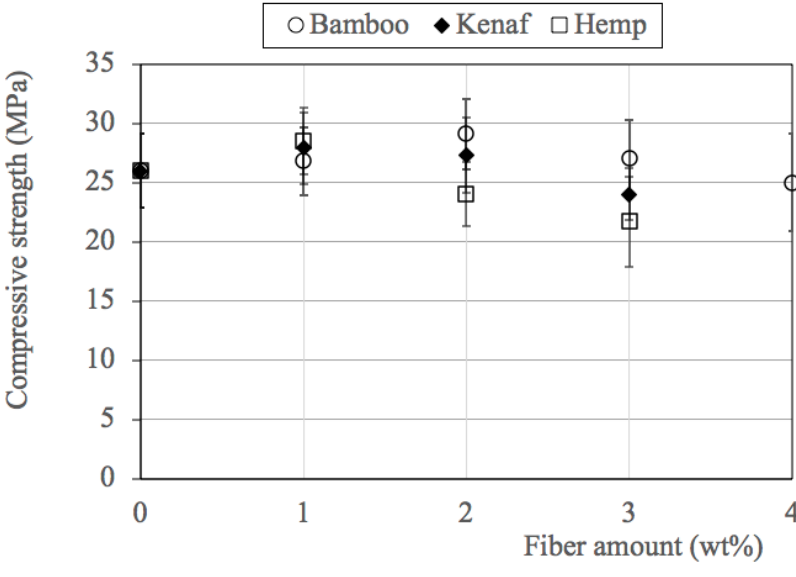
Figure 9. Compressive strength of the investigated materials.